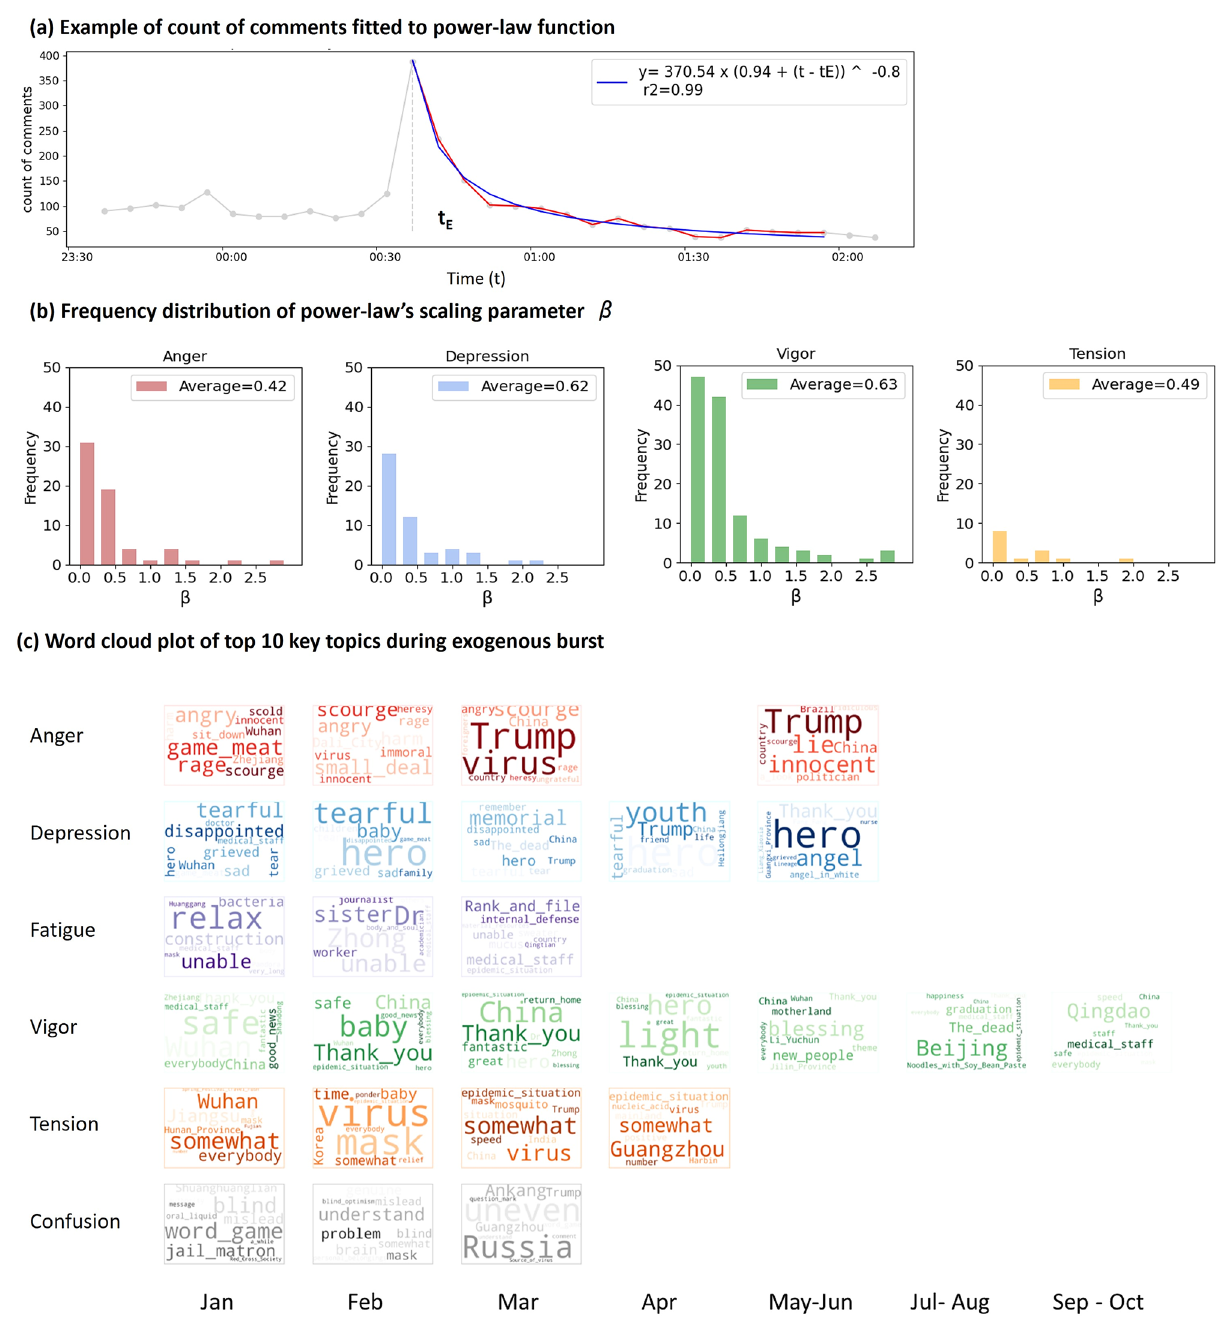
Figure 7. Features of exogenous burst. ( a ) An example of comment count time series that we categorized under exogenous burst. The post-burst part can be fitted nicely to power-law function with exponent equals to 0.8. ( b ) Histogram chart of power-law exponent β for each emotion ( Fatigue and Confusion are not included here because they rarely have exogenous burst periods). Typical β value ranges from 0.42 to 0.63 for different emotions. ( c ) Word cloud chart visualizes the top 10 topic words of comments under exogenous period each month. The larger the font is, the more frequently the word occurs. Because the occurrence of exogenous bursts after May became rare, we visualized the key topics every two months after May. Those months with little or no exogenous burst period are left blank due to lack of